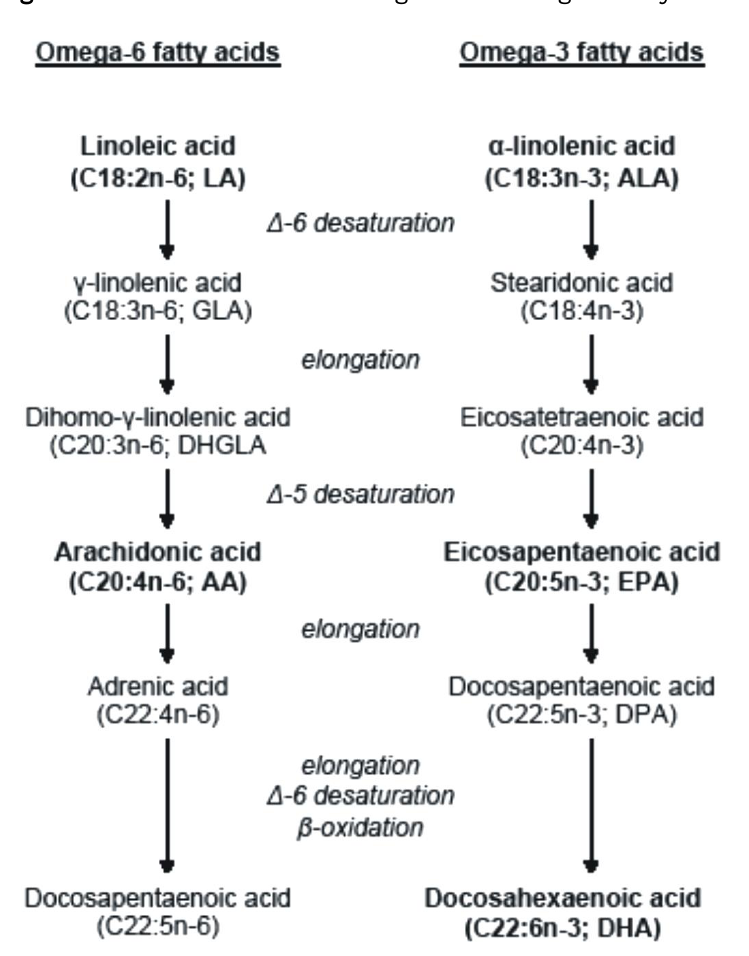
Figure 1. Metabolism of the omega-6 and omega-3 fatty